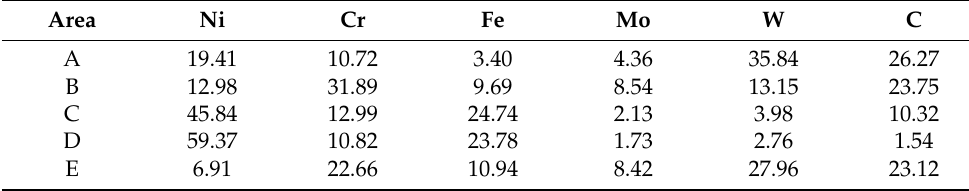
Figure 4. SEM image of the different coatings ( a ) 0 WC; ( b ) 5 WC; ( c ) 15 WC; ( d ) 20 WC. A—M 7 C 3 type carbide hard phase, B—Cr-rich carbide hard phase, C—Secondary dendritic structure, D—Substrate structure, E—High melting point particle. Table 3. EDS analysis of the coatings